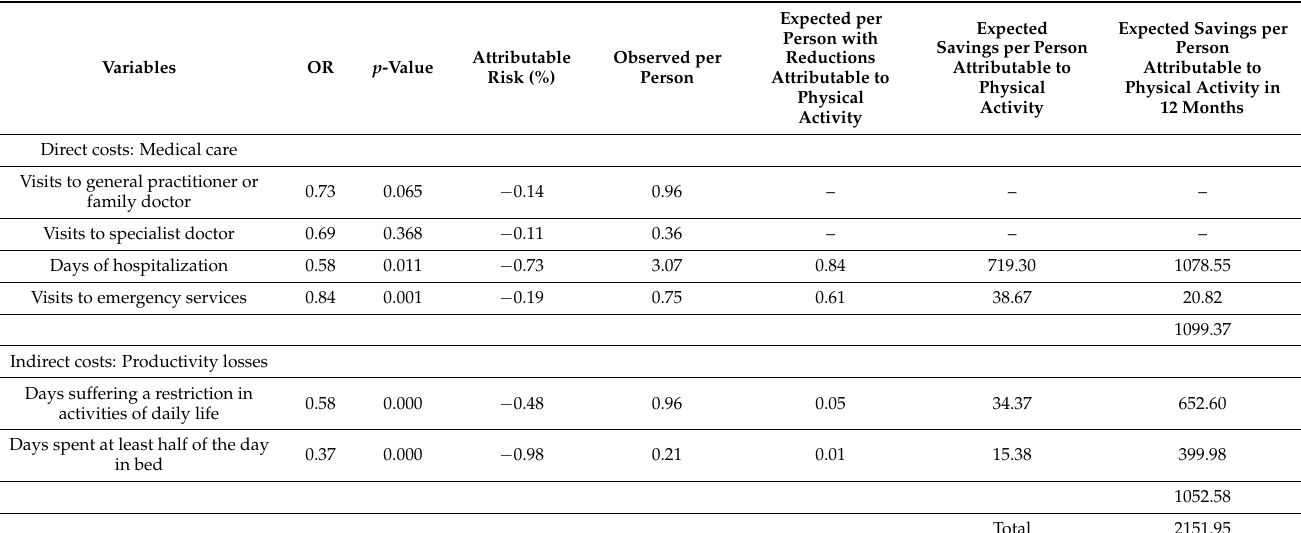
Table 3. Attributable savings to physical activity per patients: OR for adjusted binomial multivariable regression models of the independent effect of physical activity in the dependent